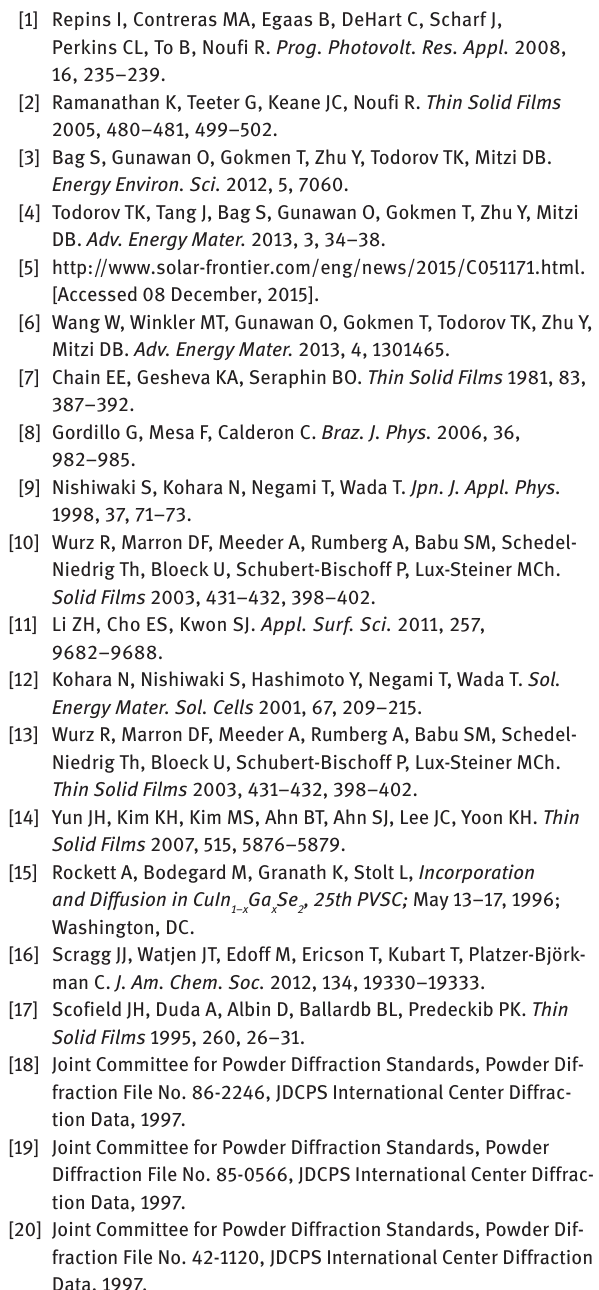
FIgure 8: SEM cross-section of (A) CIGSSe/double-layer Mo/glass substrate and (B) CIGSSe/single-layer Mo/glass substrate selenized at 500 ° C for 20